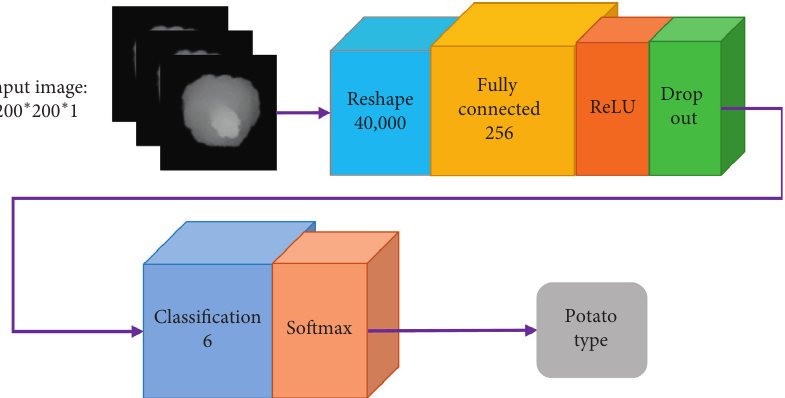
Figure 4: Softmax regression model architecture.